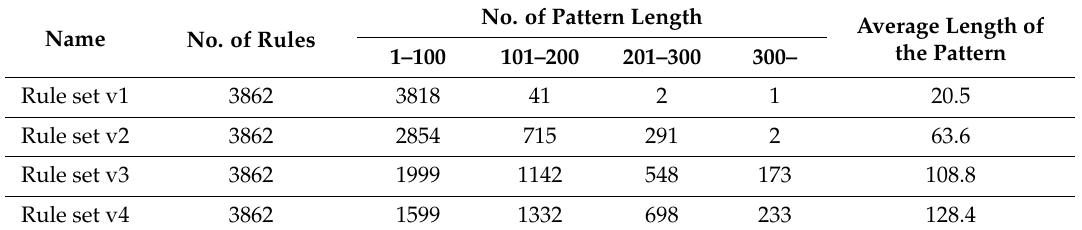
Table 8. Different rule sets.